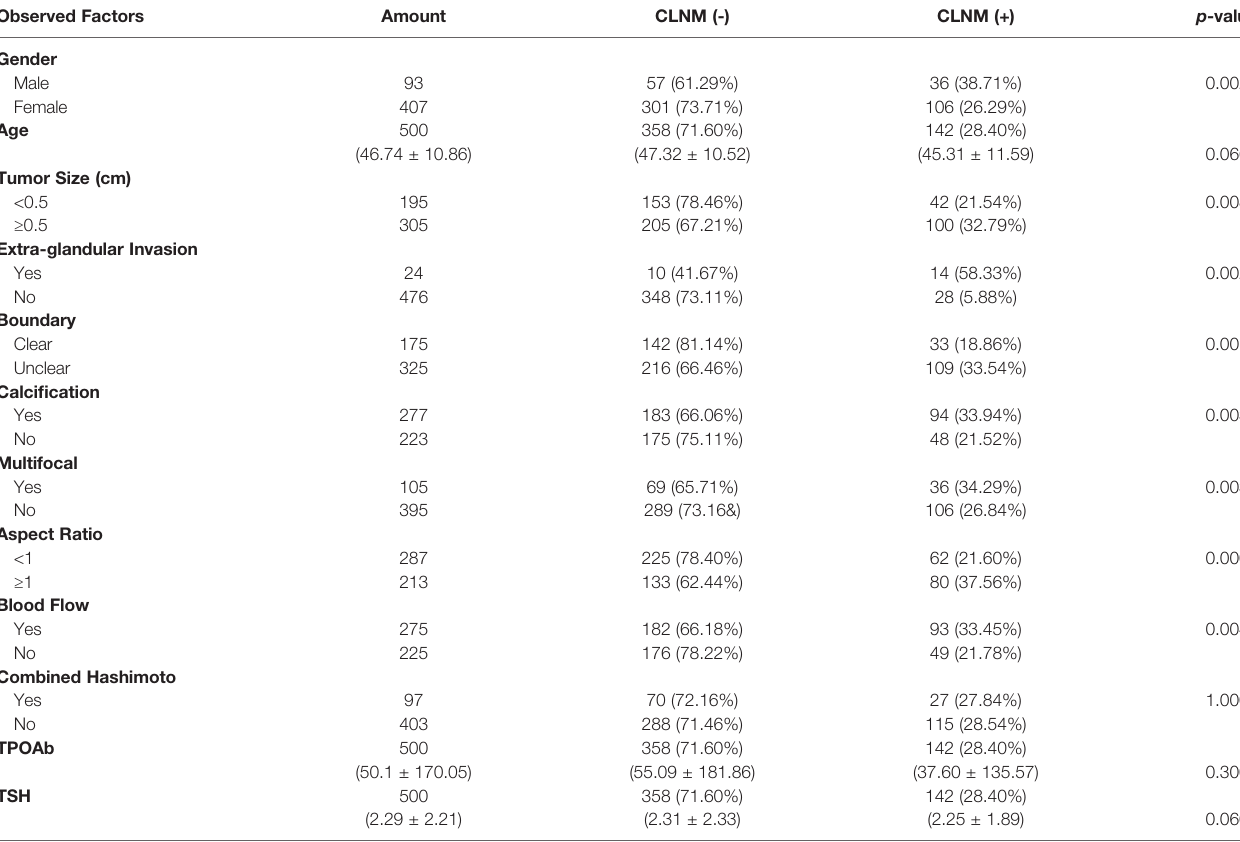
TABLE 1 | Relationship between clinical features and CLNM.